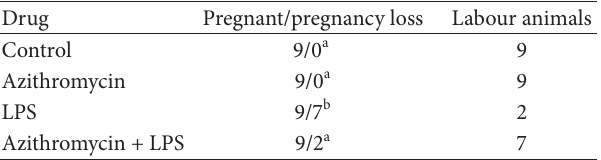
Table 1: Pregnancy rates of groups.